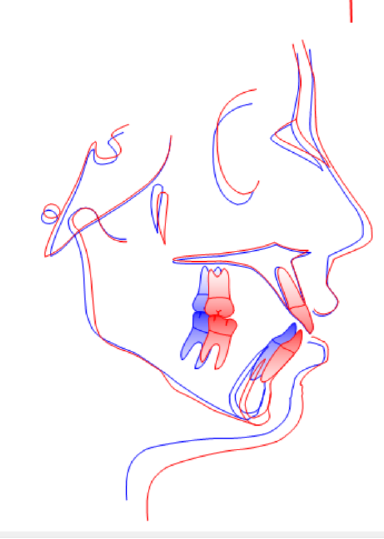
Figure 15. Post-treatment lateral cephalogram and panoramic radiograph.